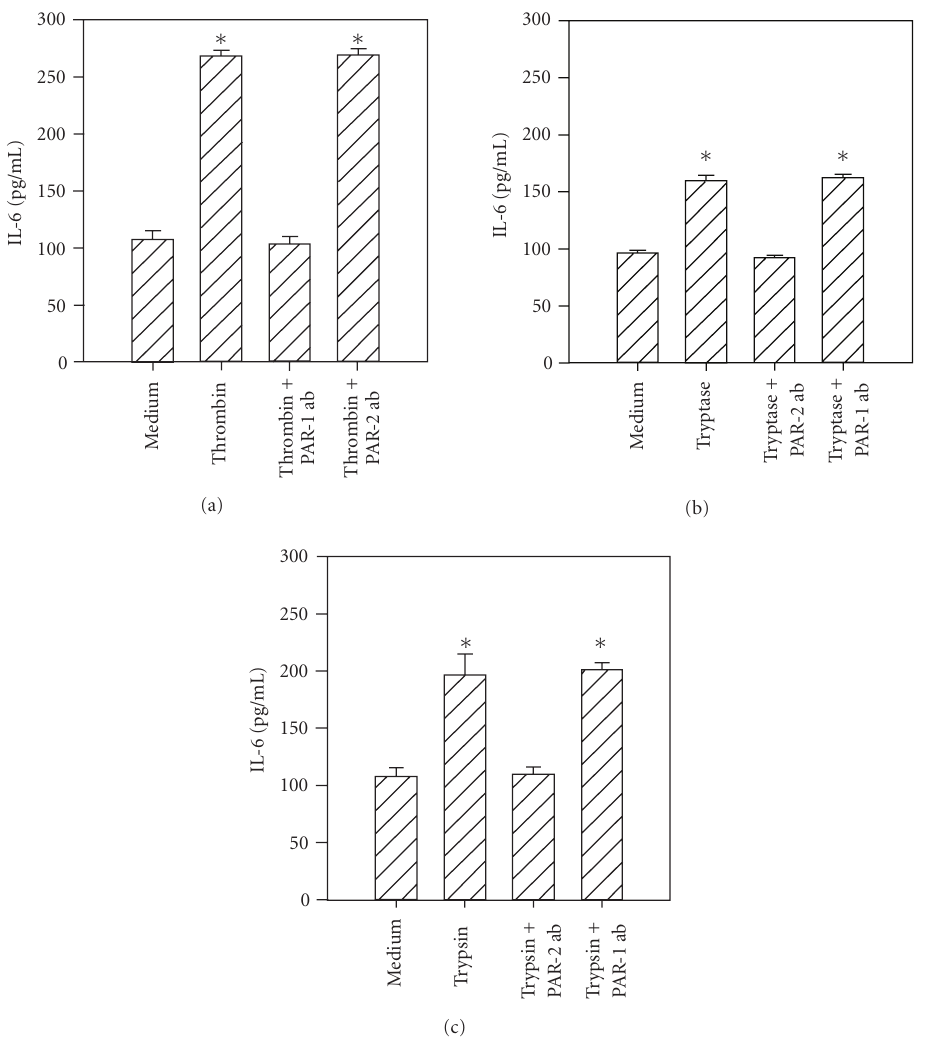
Figure 6: PAR1 and PAR2 neutralizing antibodies selectively inhibit the e ff ects of thrombin, tryptase, and trypsin . HCEC monolayers were incubated for 15 minutes with a cocktail of PAR1 blocking antibodies, ATAP-2 (25 μ g/mL), and WEDE 15 (25 μ g/mL), or the PAR2 blocking antibody, SAM11 (25 μ g/mL), prior to stimulation for 24 hours with thrombin (50 nM) (a), tryptase (50nM) (b), and trypsin (50nM) (c). IL-6 levels in the culture media were then assayed by ELISA. Each value presented is the mean + / − SD of quadruplicate determinations. ∗ indicates P < .05 when compared to medium